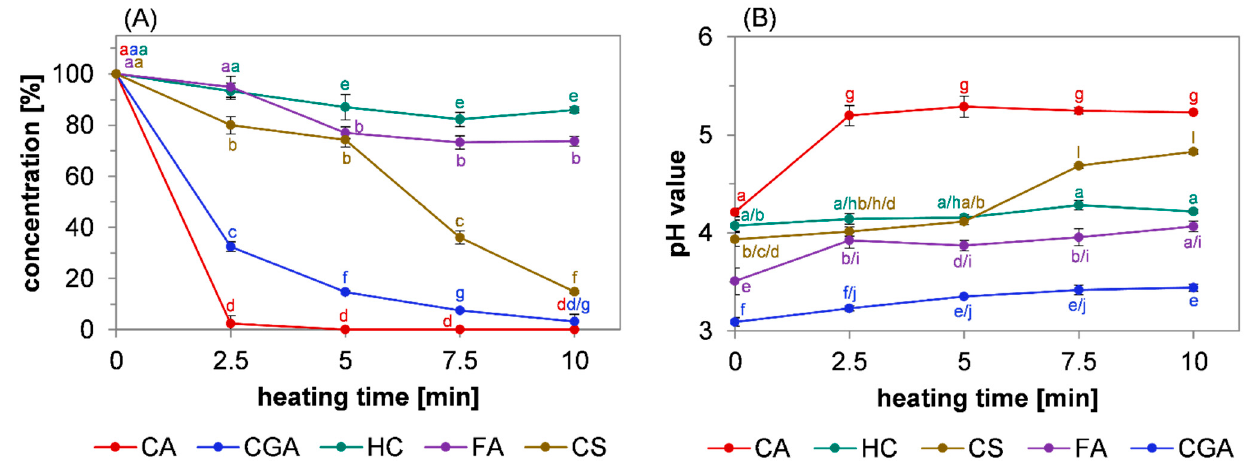
Figure 2. Reactivity of different hydroxycinnamic acid derivatives. Heat-induced ( A ) conversion of caffeic acid (CA, red line), 5- O -caffeoylquinic acid (CGA, blue line), hydrocaffeic acid (HC, green line), para -coumaric acid (CS, brown line), and ferulic acid (FA, purple line) over the course of roasting at 220 ◦ C and ( B ) changes in the pH values of the methanolic extracts. Data were analyzed by two-way ANOVA and T UKEY ’s test ( p < 0.05). Statistical differences between the data points are designated by different letters.